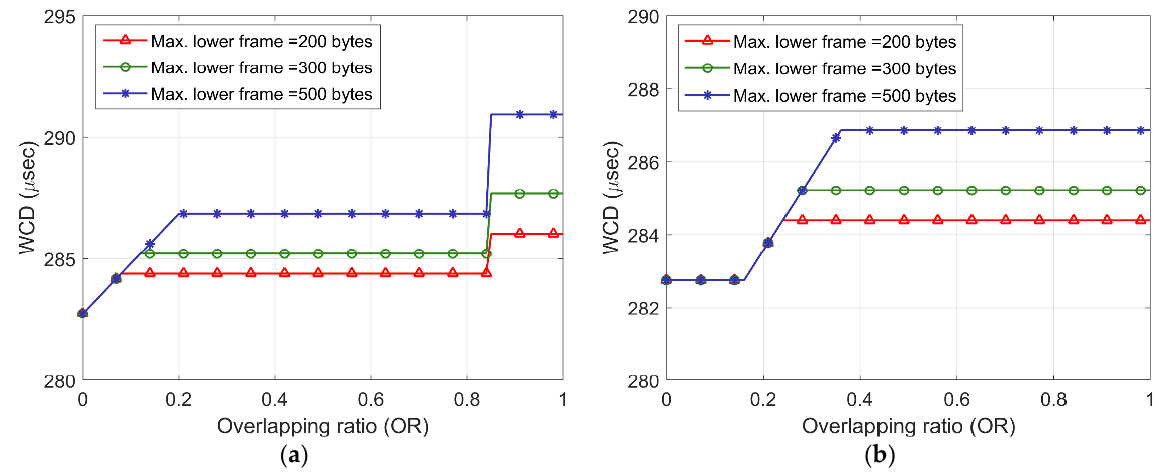
Figure 14. The worst-case end-to-end delay ( WCD) vs. lower-priority overlapping with different sizes of the lower-priority frame ( f max ): ( a ) opening-edge overlapping case and ( b ) closing-edge overlapping